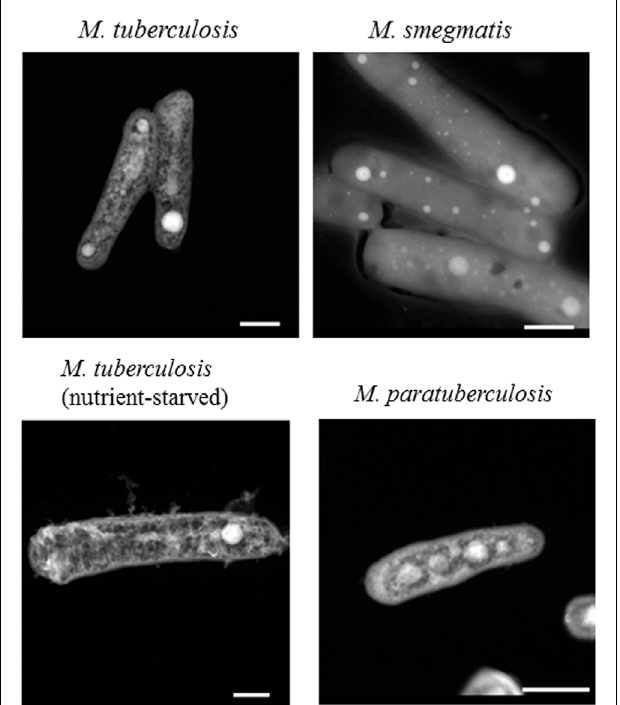
FIGURE 1 | Polyphosphate granules in Mycobacteria . Mycobacterial isolates were fixed as whole-cell mounted, and imaged using an FEITitan 80-200 STEM. Selected images show representative samples from at least two biological replicates, with multiple bacteria imaged within each replicate. Nutrient-starved M. tuberculosis was incubated in water for 21 days, and all other images are from bacteria grown to late-log phase in 7H9 liquid media. Scale bars (lower right) represent